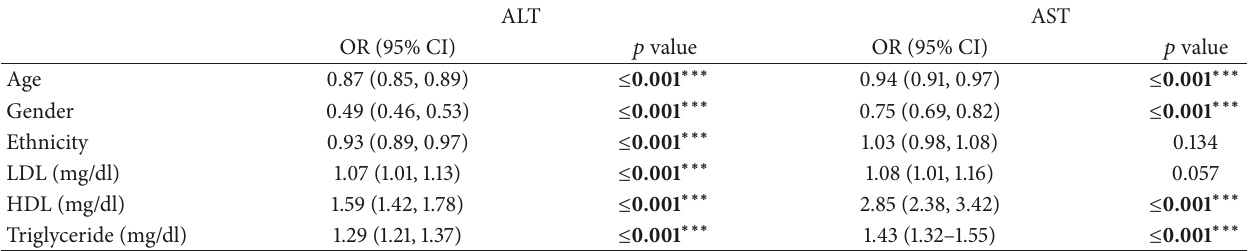
Table 6: Predictors of AST and ALT level on regression (adjusted